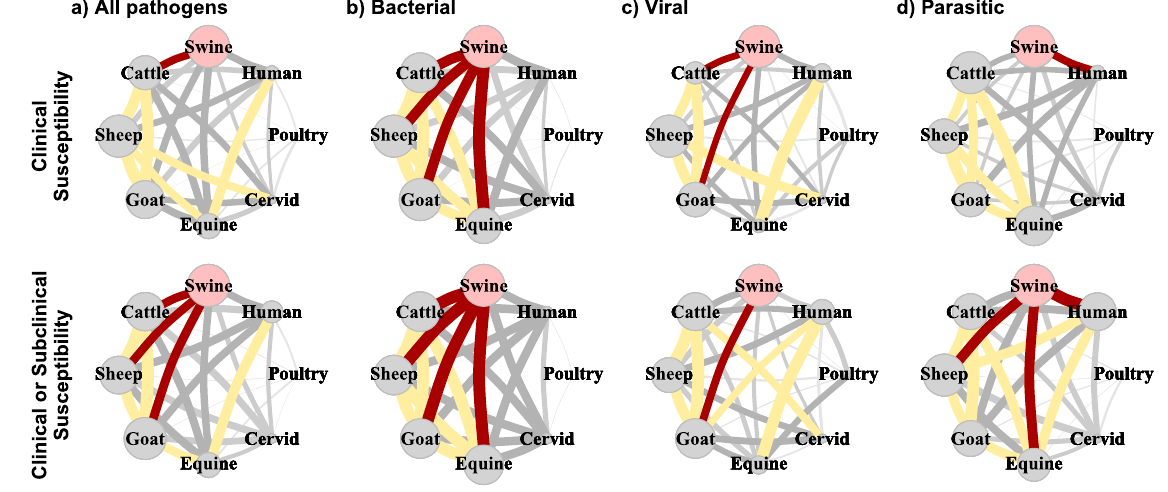
Figure 1. Transmission potential networks used in this study created by connecting two host species if they were susceptible to the same pathogen causing clinical or subclinical disease in swine. Top row are pathogens causing clinical disease in non-swine hosts and the bottom row are all pathogens affecting non-swine hosts. Edge weight between two species is the similarity in the parasites infecting a pair of individuals calculated with the Jaccard index. Red edges denote Jaccard index in the upper 75th quartile, while light gray are edges in the lower 25th quartile. Node size indicates the relative centrality of the species group in the transmission network, calculated using the eigenvalue centrality – more central nodes are larger.